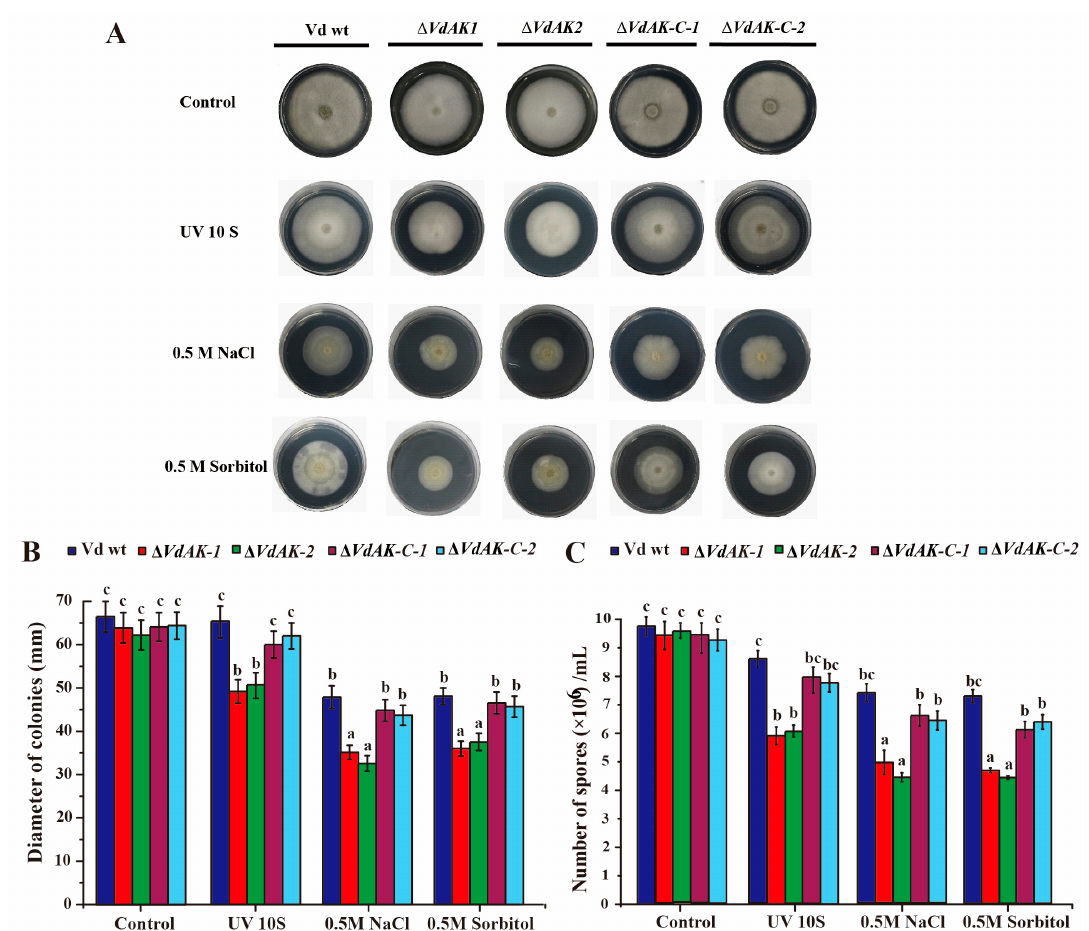
Figure 2. The deletion of VdAK compromises mycelial growth and spore production during abiotic stress. A 10 µ L drop of 10 6 spores / mL was placed in the center of Czapek Dox agar in a petri dish. Colony morphology ( A ), colony diameter ( B ), and spore production ( C ) of disruption ( ∆ VdAK ) and complementation ( ∆ VdAK-C ) mutants and wild-type Vd strain exposed to three abiotic stresses were analyzed after 4 weeks. Means ( ± SE) from three independent experiments were analyzed for significant di ff erences among treatments using Duncan’s test ( p < 0.05). Di ff erent letters above bars within a treatment indicate significant di ff erences among the strains.